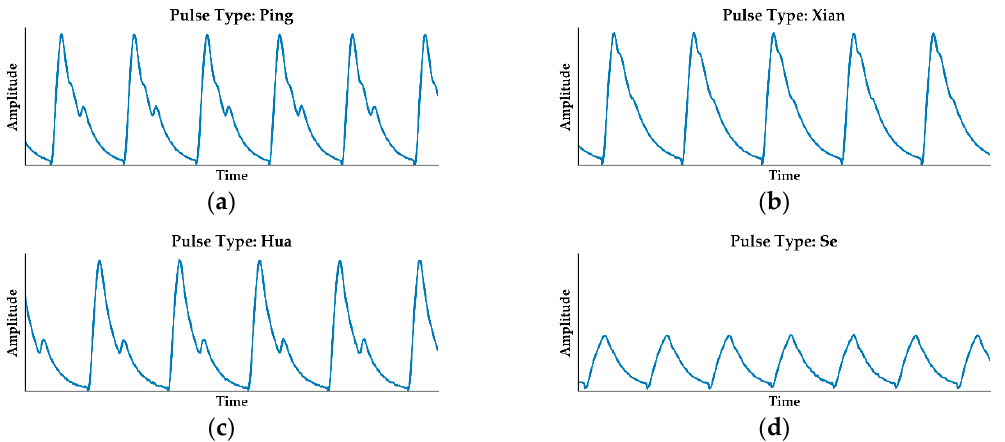
Figure 1. Four typical types of pulse waveforms. ( a ) Ping pulse; ( b ) Xian pulse; ( c ) Hua pulse; ( d ) Se pulse.